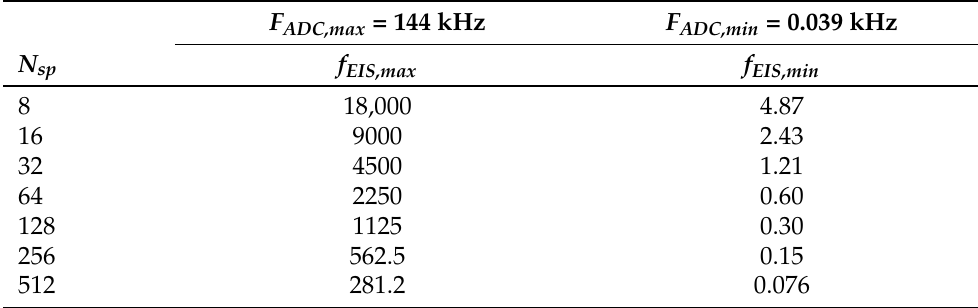
Table 5. Maximum and minimum perturbation frequency limited by